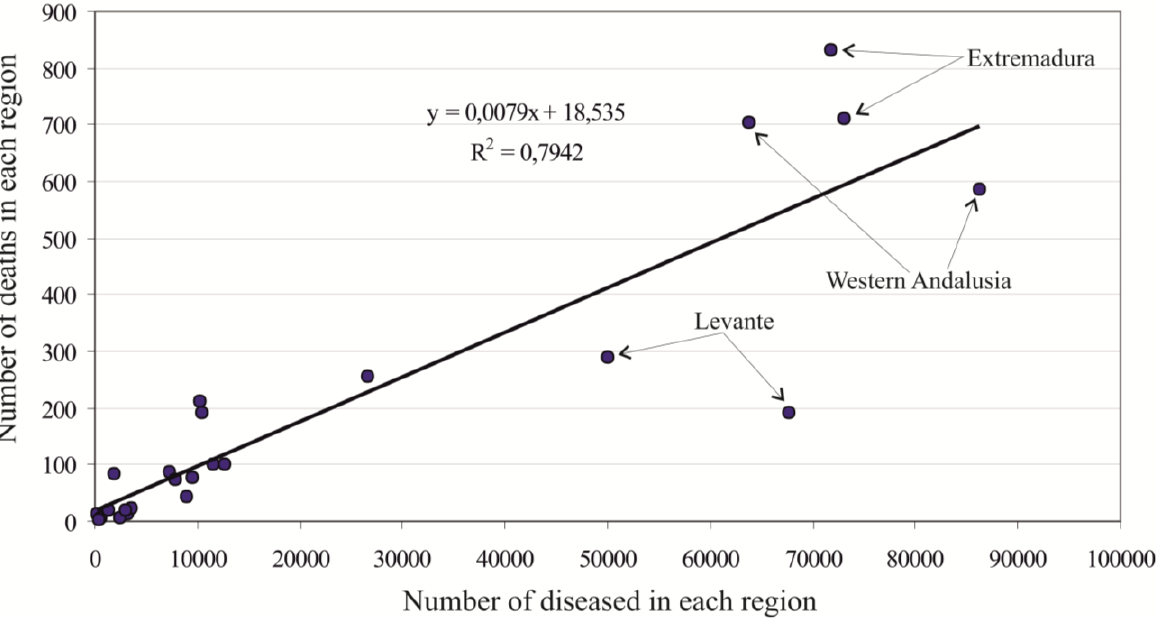
Figure 5. Scatterplot of the number of deaths (1913 and 1916) in each Spanish region.